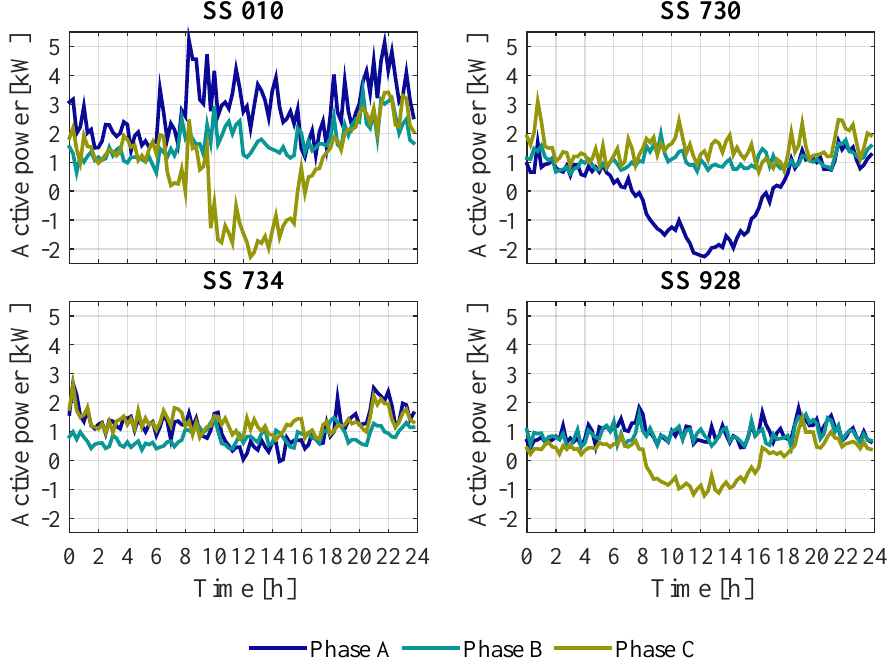
Figure 11. Net active power profile for phases A, B and C at each SS for scenarios (3) and (4). Note that both scenarios share the same net active power profile, so results can be applied to both